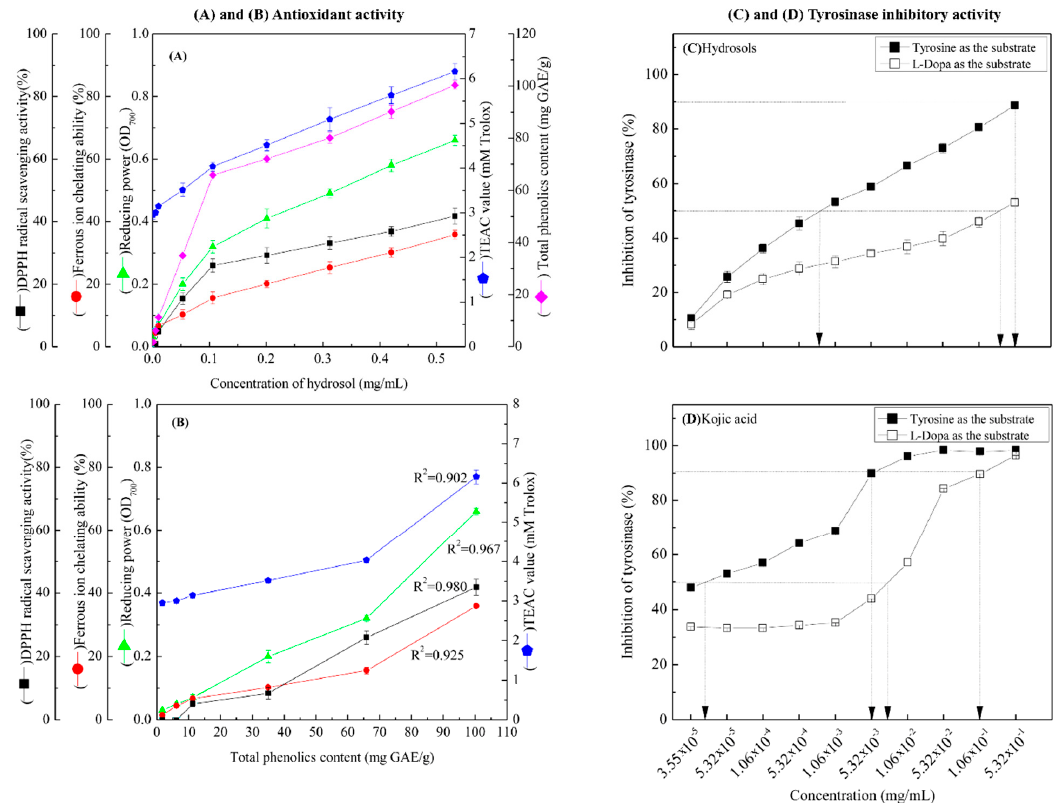
Figure 3. ( A ) Antioxidant activities of COK hydrosol produced by steam distillation; ( B ) overview of the relationships between total phenolic contents (TPCs) in hydrosol and antioxidant activities; ( C , D ) dose-dependent inhibition of monophenolase and diphenolase activities of tyrosinase using L -tyrosine and L -DOPA as substrates, respectively. Values represent means ± standard deviations (SD; n = 3.).